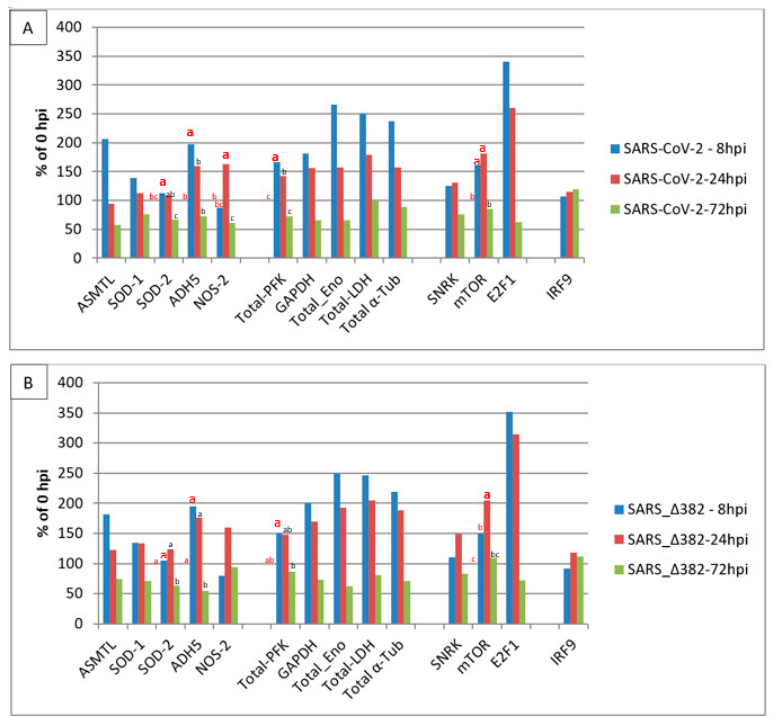
Figure 1. Transcript accumulation of selected ReprogVirus marker genes in human nasal epithelial cells infected with two SARS-CoV-2 variants at 8 h post-infection (hpi), 24 hpi and 72 hpi. Transcript levels are averages from three cell origins (donators/cell cultures) given in % of 0 hpi. ( A )—SARS-CoV-2 (virus originally discovered); ( B )—SARS-CoV-2 Δ 382. Two-way ANOVA analysis identified differential transcript level changes along early times between the original virus and the mutant (marked by enlarged, fat letters). Different letters indicate significant differences between net RPKM for α = 0.05. Letters on the 100% horizontal line correspond to 0 hpi. The result of two-way ANOVA analysis for all genes can be consulted in Figure S1.